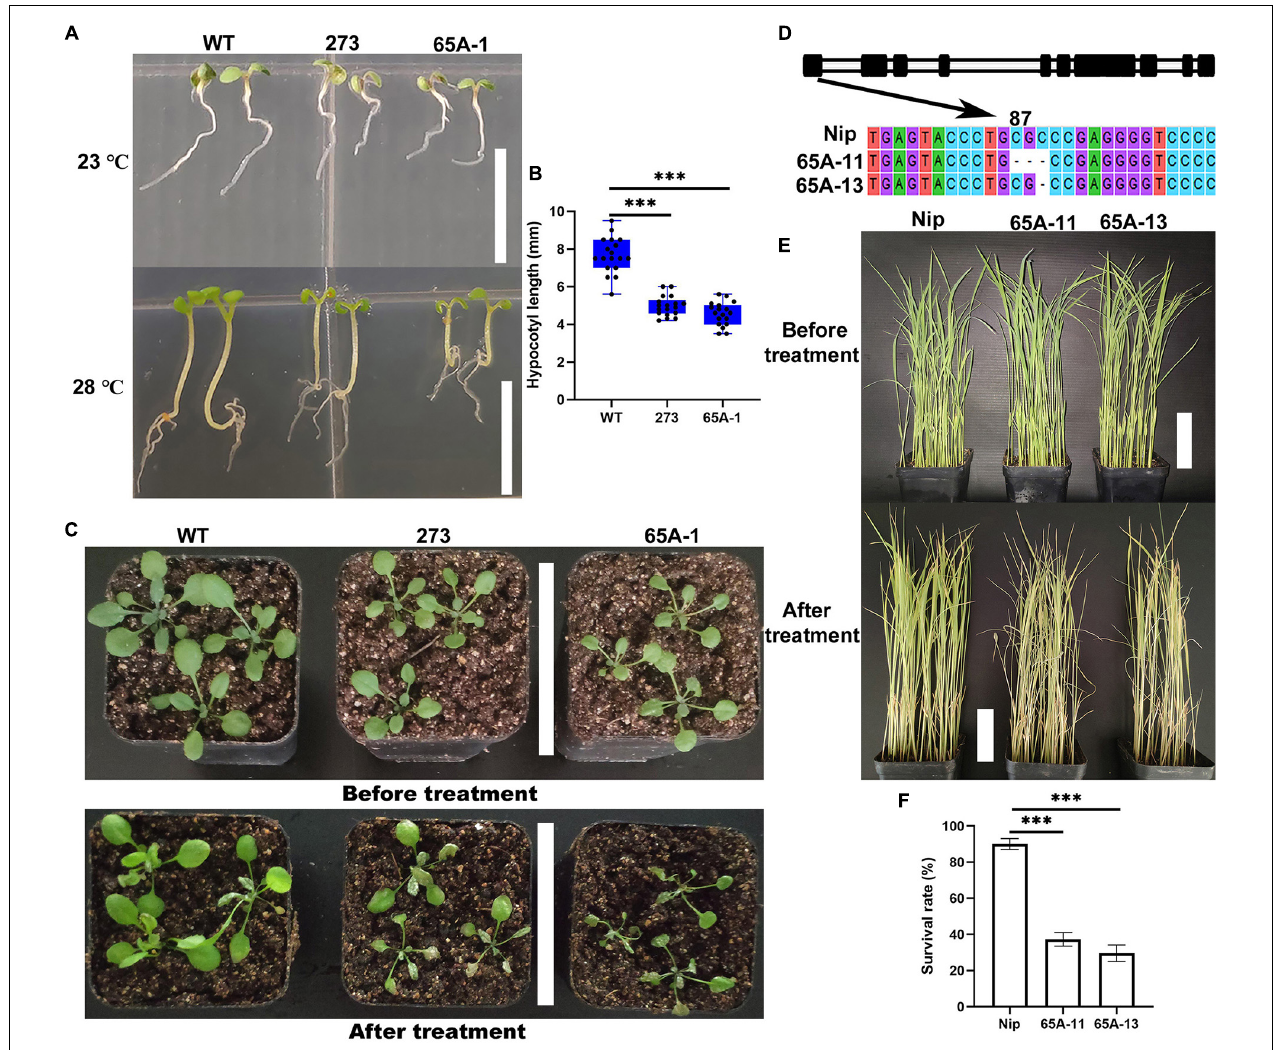
FIGURE 9 | The U2AF65A mutations reduced the tolerance of Arabidopsis thaliana and rice plants to high temperature. (A) Hypocotyl phenotype of Arabidopsis thaliana grown vertically for 7 days at 23 ◦ C and 28 ◦ C; bar = 10 mm. (B) The hypocotyl length of plants (18 plants per replicate). (C) Growth of 3-week-old Arabidopsis seedlings exposed to high temperature for approximately 4 days; bar = 7 cm. (D) Identification of the rice U2AF65A mutant. The black column represents the exon sequence of OsU2AF65A. The 65A-11 and 65A-13 mutants lost respectively 3 bases (CGC) at position 87 and 1 base (C) at position 89 of the first exon. (E) Growth of 3-week-old rice plants before and 11 days after the high-temperature treatment; bar = 7 cm. (F) Survival rate of rice; plants were curled and withered leaves were considered dead. Experiments (A,C,E) were repeated three times with similar results. Data in (B,F) are presented as the means ± SD of three independent experiments, and differences between the mutants and wildtype are indicated by asterisks ( ∗∗∗ p < 0.001) according to ANOVA and Tukey’s post hoc